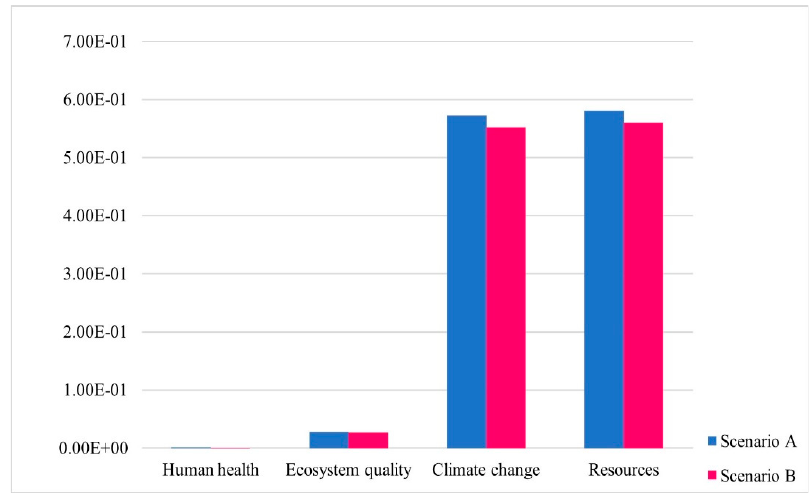
Figure 6. Single score LCIA results for scenario A and B.